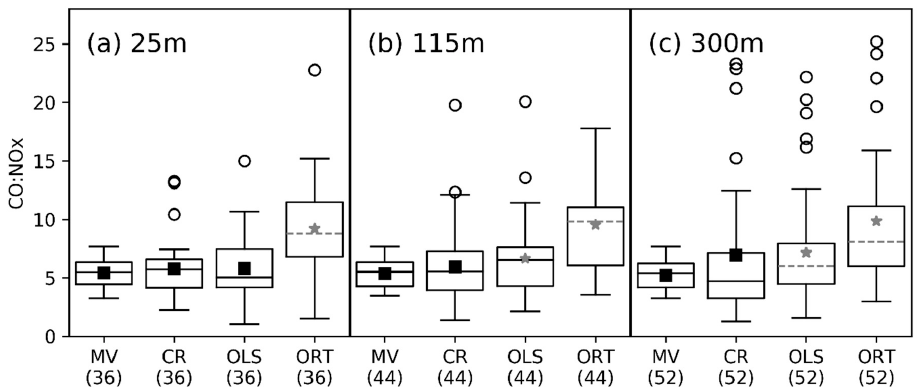
Figure 2. Comparison of emitted CO:NO x from EPA’s MOtor Vehicle Emissions Simulator (MOVES) with ∆ CO: ∆ NO x values from 3 ambient-based methods. Distribution of emitted CO:NO x from MOVES (“MV”), from the cross-road gradient method (“CR”), from OLS regressions and from orthogonal regressions (“ORT”) at the 25 m downwind monitor ( a ), the 115 m downwind monitor ( b ) and the 300 m downwind monitor ( c ). Numbers below each boxplot represent sample size (n). Boxes represent interquartile range; mid-lines represent median values; and symbols represent mean values. When the Mann Whitney test is statistically di ff erent from MOVES, the median line is gray and dashed. When the Welch’s t -test is statistically di ff erent from MOVES, the mean is a star and gray. Note that there are 3 outlier points o ff the scale in the plot: ORT at 115 m with a ∆ CO: ∆ NO x of 30.5; CR at 300 m with a ∆ CO: ∆ NO ∆ CO: ∆ NO x of 44.4; ORT at 300 m with a x of